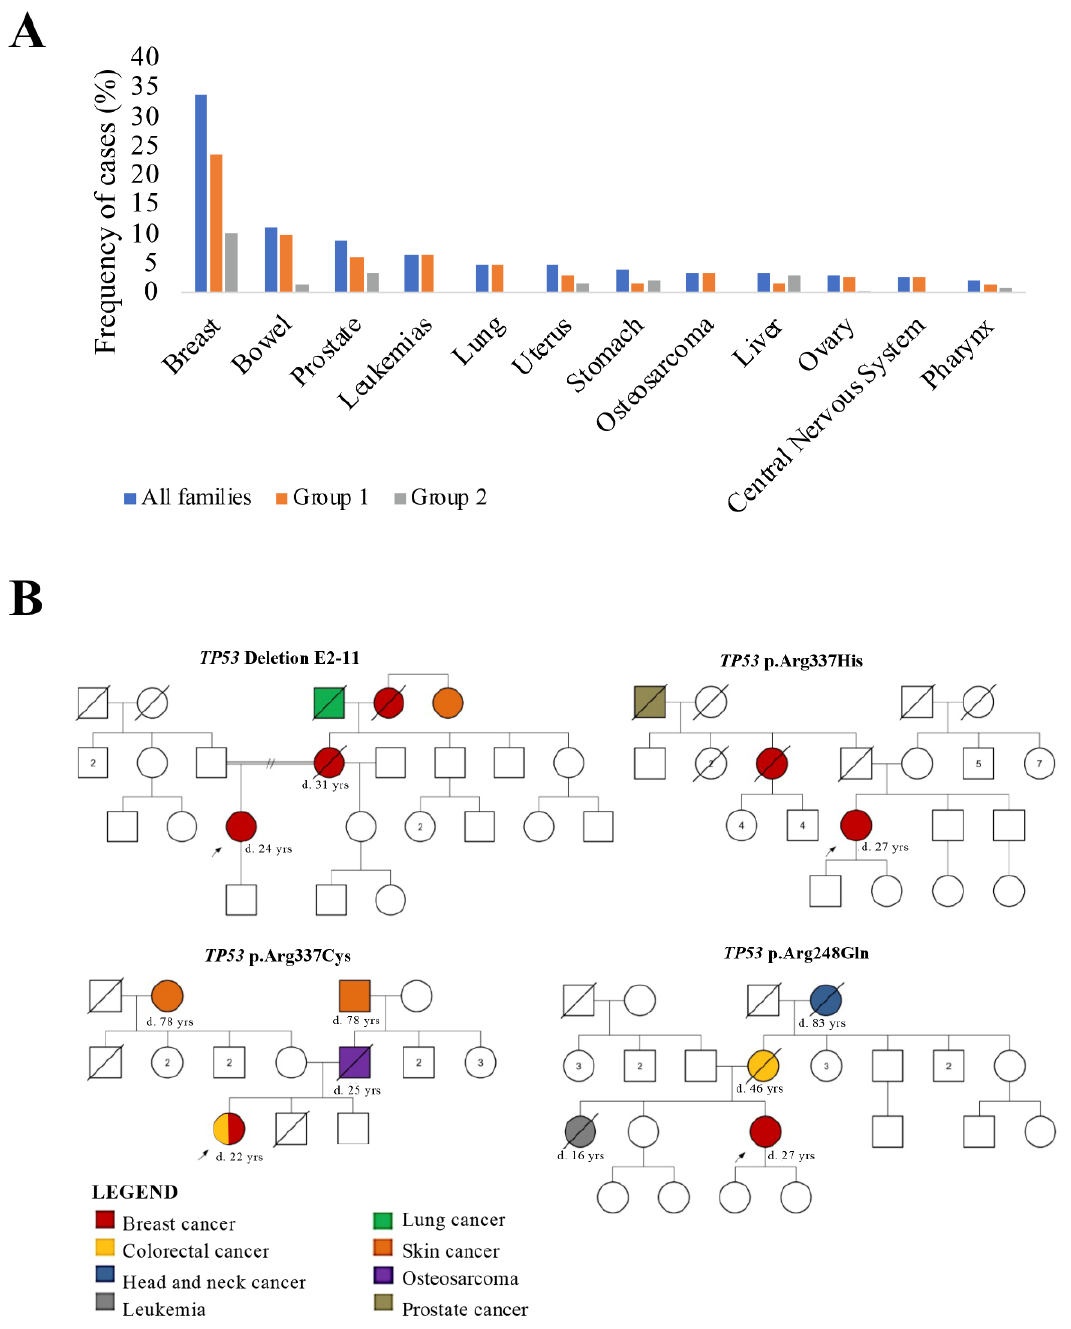
Figure 1. ( A ) Tumor types reported breast cancer patients and their family members. ( B ) Pedigrees of the index patients with germline TP53 pathogenic variants. The age at diagnosis is indicated by (d.).